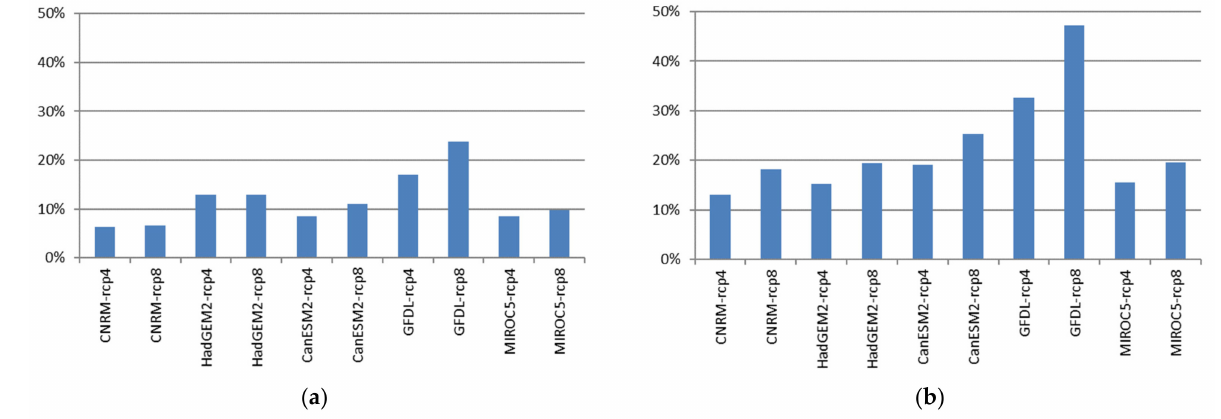
Figure 6. Changes in evapotranspiration: ( a ) 2010–2039, ( b ) 2040–2069.